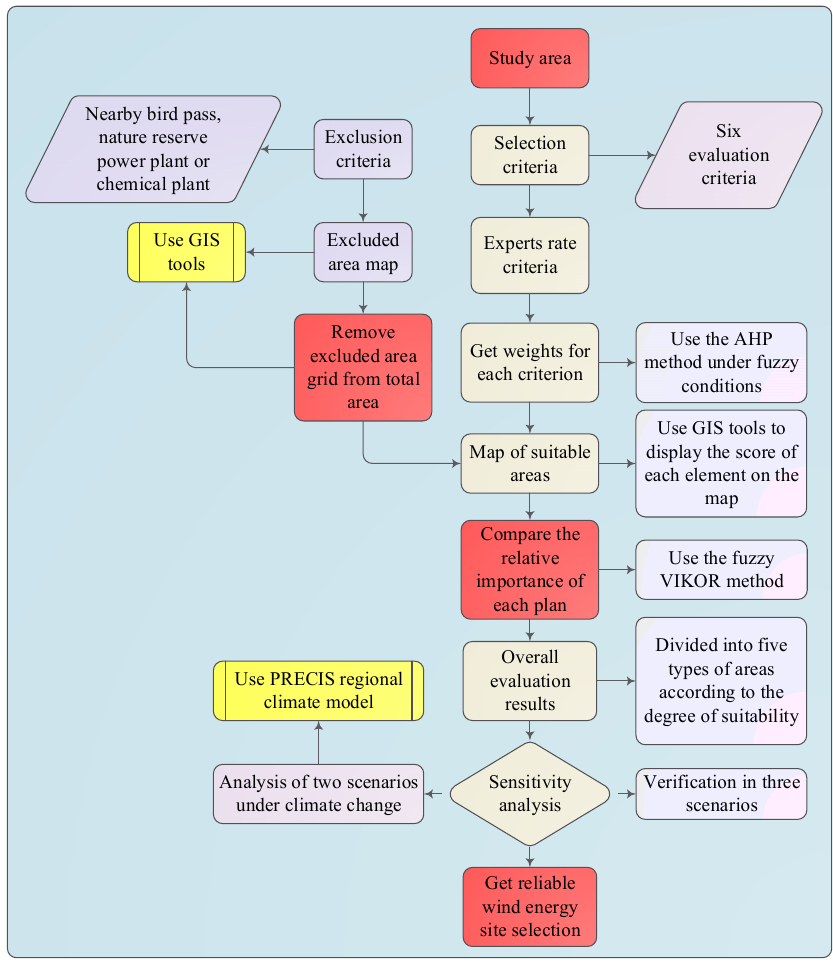
Figure 2. General framework of wind farm site selection.